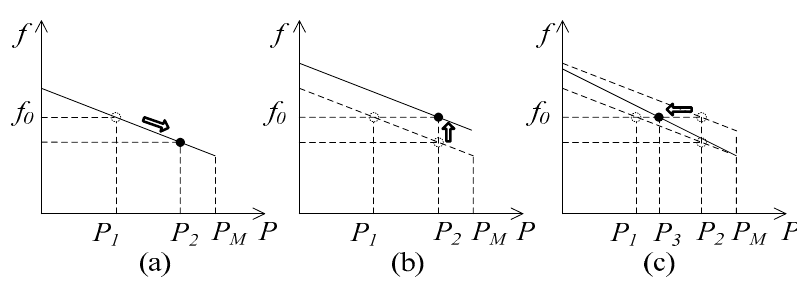
Figure 6. Speed droop control ( a ) primary response; ( b ) secondary response; ( c ) tertiary response.